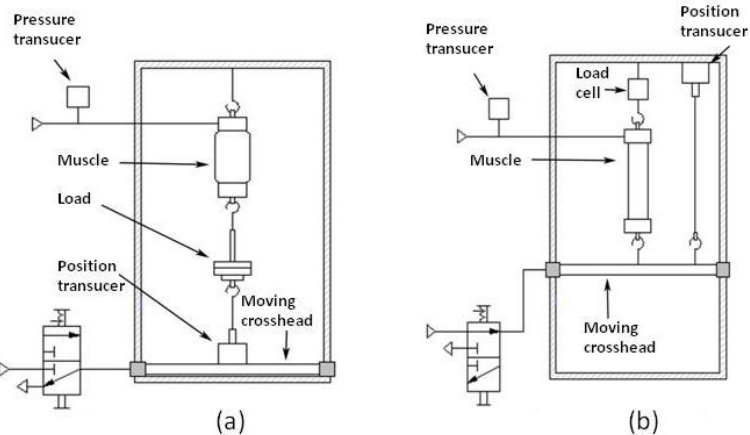
Figure 9. Test bench: ( a ) configuration for length-pressure tests; ( b ) configuration for force-pressure